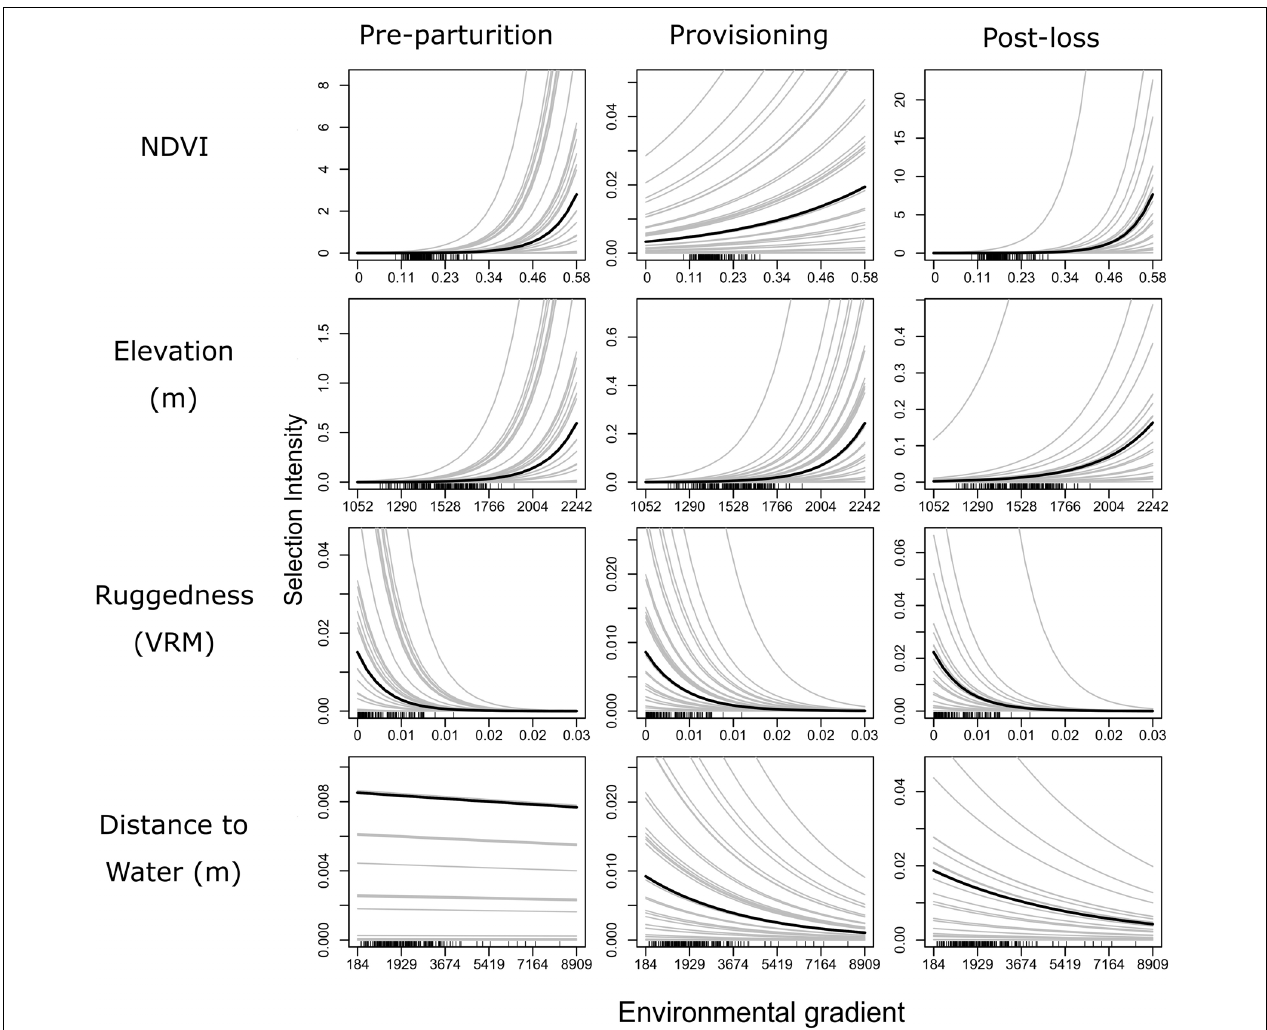
FIGURE 4 | Partial dependence plots illustrating the expected influence of each of four environmental gradients (rows of panel grid) on relative resource selection of female mule deer during pre-parturition ( n = 68), while provisioning young ( n = 67), and post-juvenile mortality ( n = 20) on the Mojave National Preserve, California, United States, 2013 – 2016. Solid black lines indicate population level patterns, while gray lines represent patterns of selection for individual mule deer. All predictions were derived from a GLMM model fitted to GPS collar data, with random intercepts and slope terms fitted to individual deer. This figure illustrates the extreme variation in patterns of selection among individuals and the varying degree of differences in patterns of resource selection among reproductive